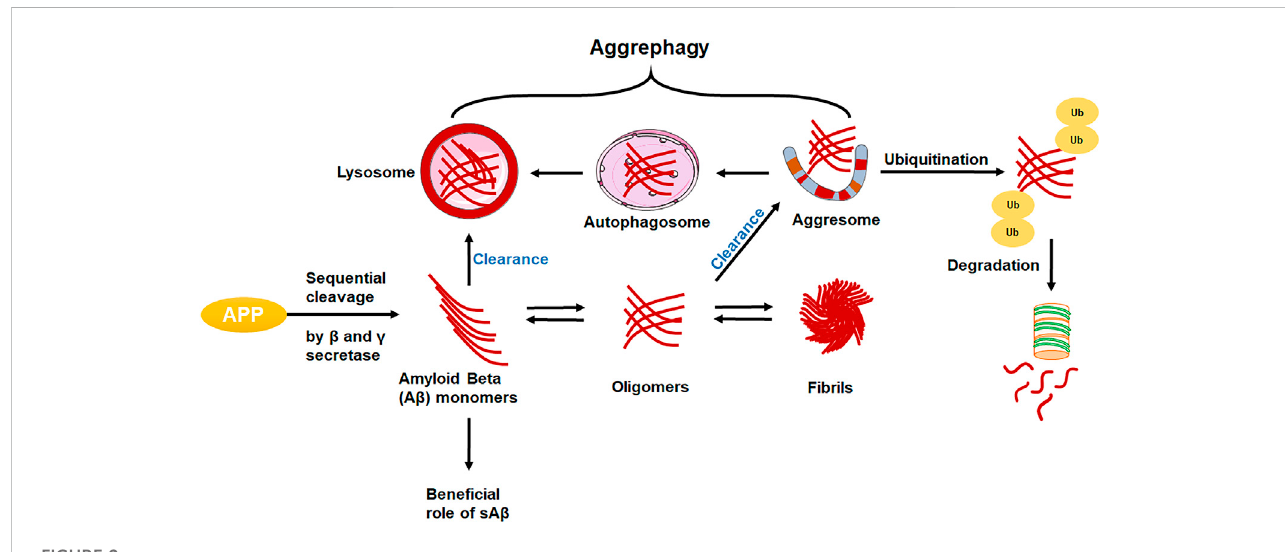
FIGURE 2 Assessment of protein in AD